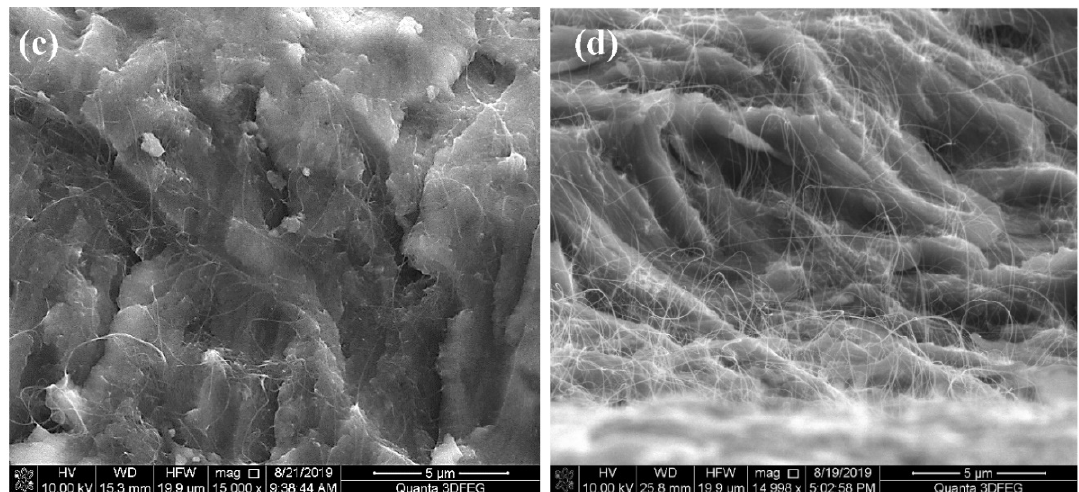
Figure 3. FE-SEM images × 15,000 magnification of flexural fracture surface of ( a ) neat epoxy; ( b ) 0.4 wt% as-received MIRALON ® pulp/epoxy; ( c ) 0.8 wt% as-received MIRALON ® pulp/epoxy; ( d ) 1.5 wt% as-received MIRALON ® pulp/epoxy.